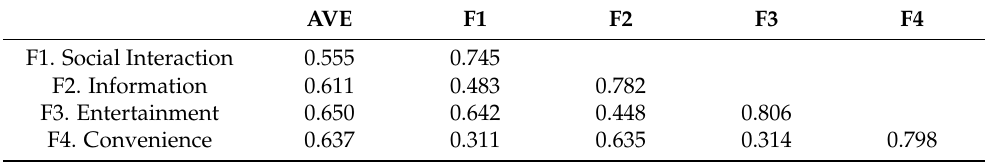
Table 4. Correlations among All Constructs: Level 1 Model.